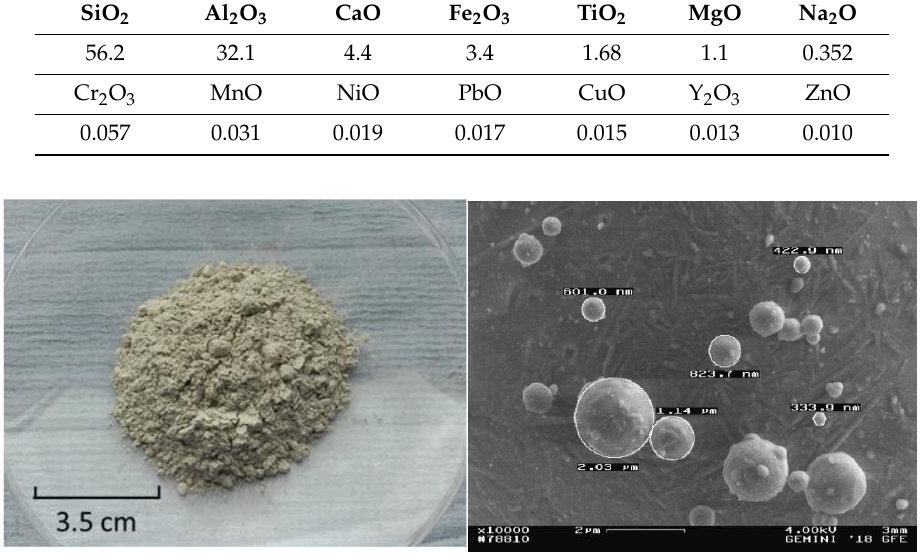
Figure 3. Fly ash powder ( left ) and SEM analysis ( right ).